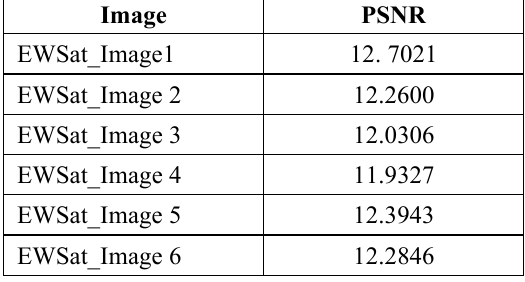
Table 3. PSNR of Encrypted Raster Data